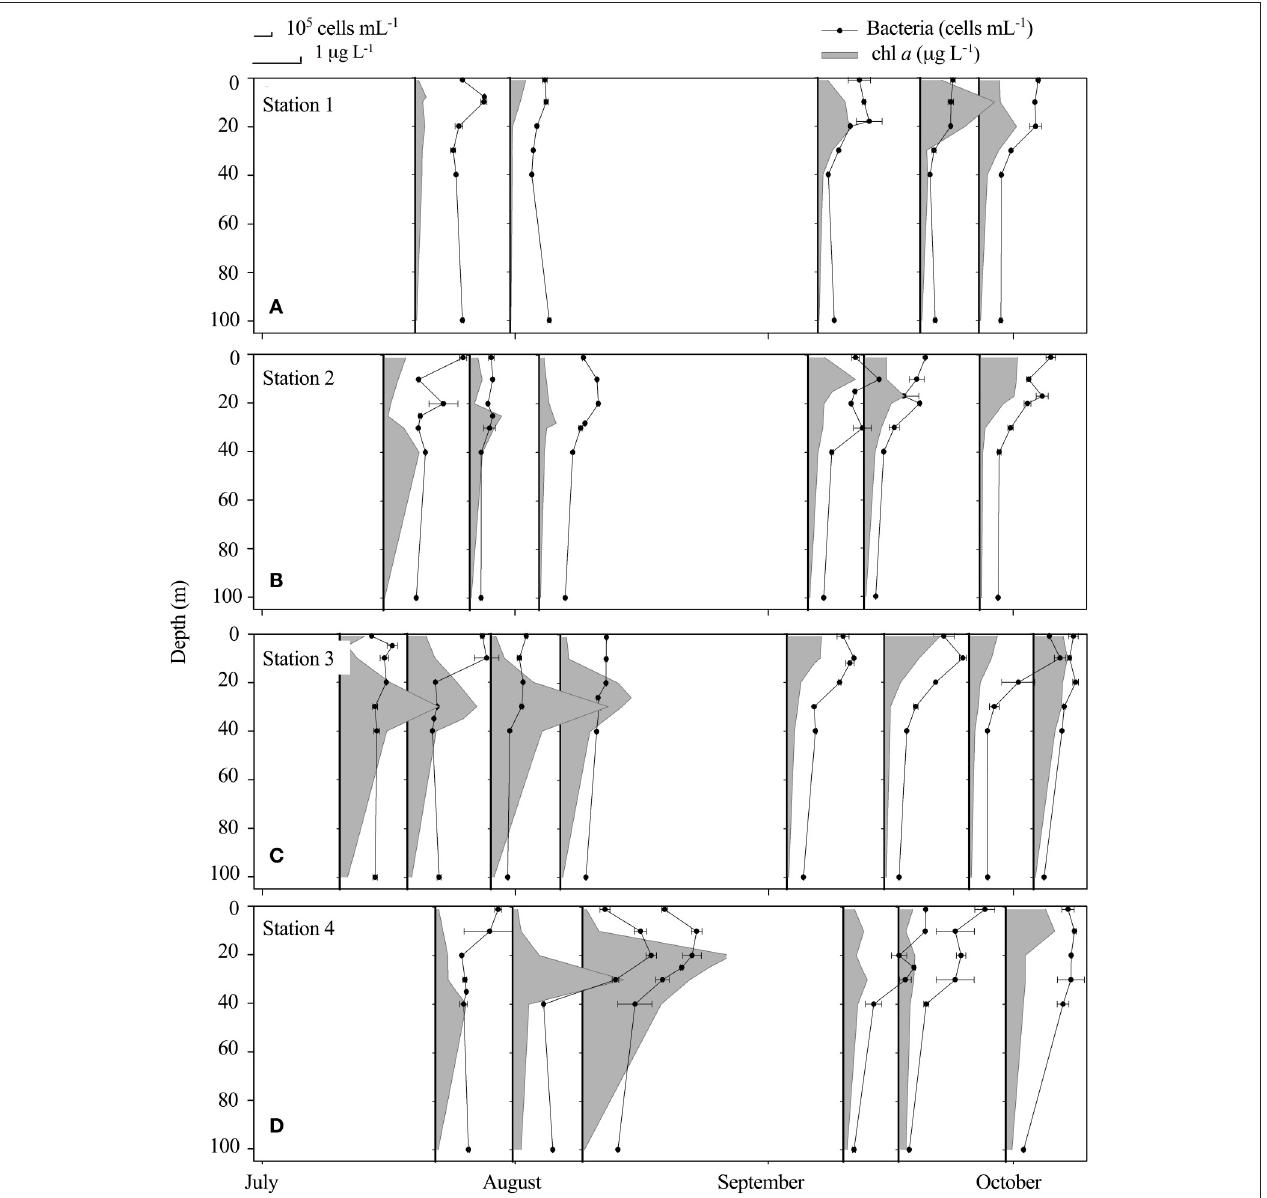
FIGURE 3 | Vertical distribution (upper 100 m) at Station 1 (A) , Station 2 (B) , Station 3 (C) and Station 4 (D) of bacteria (10 5 cells mL − 1 ± SD) (black dots) and chl a (gray area) ( µ g chl a L − 1 ± SD) at the fjord stations from July to